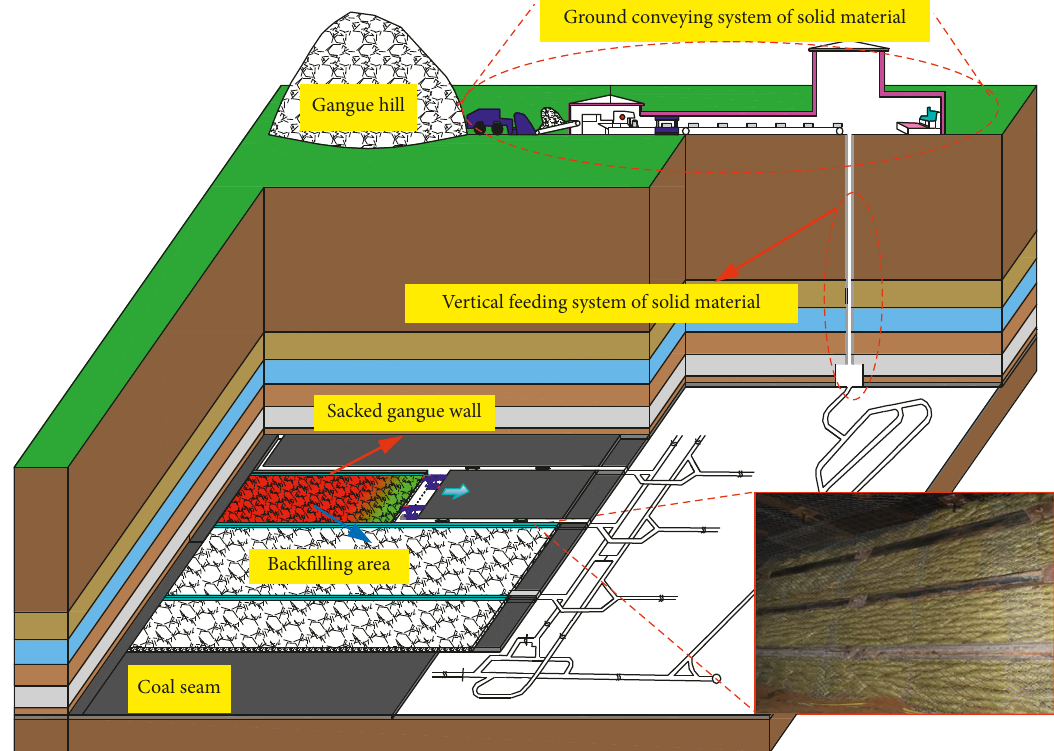
Figure 1: The transportation system of roadside support body material for backfilling